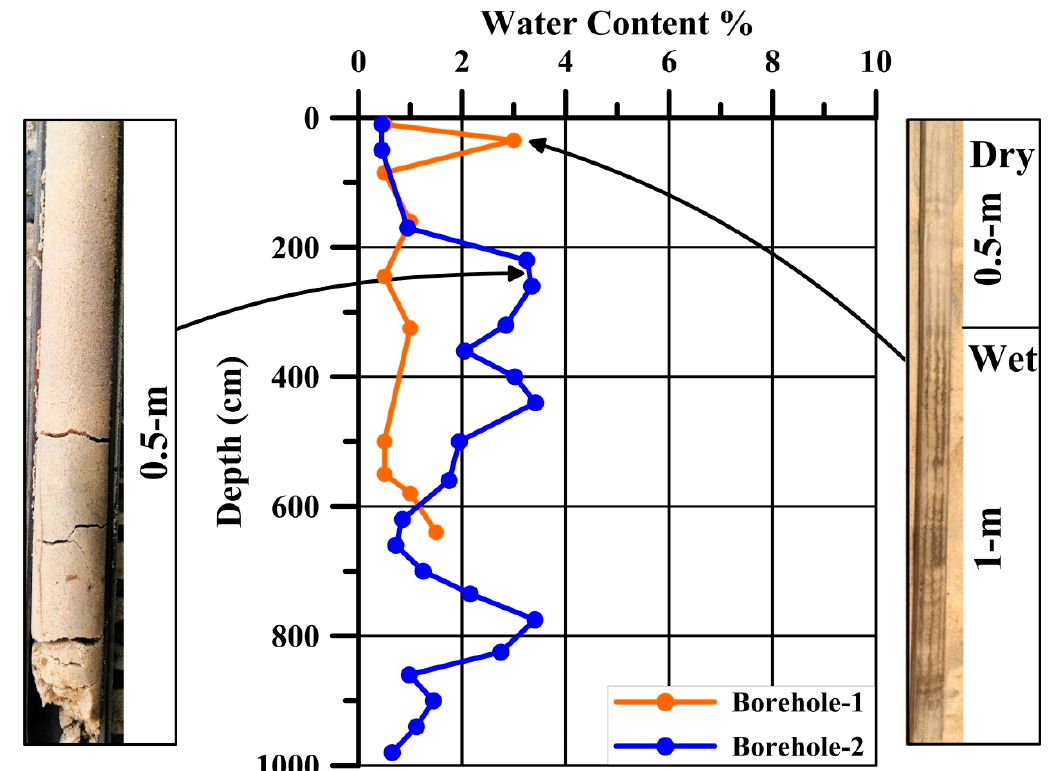
Figure 5. Water content profiles of the two boreholes.